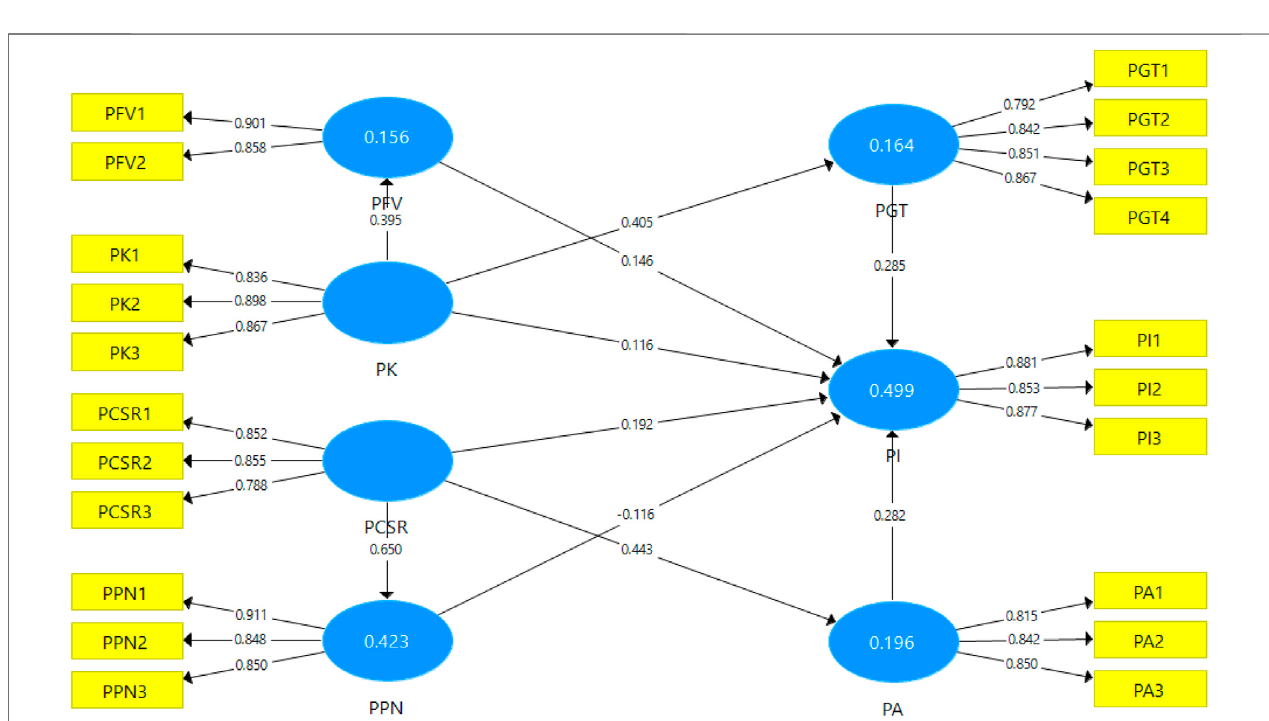
FIGURE 2 | Measurement